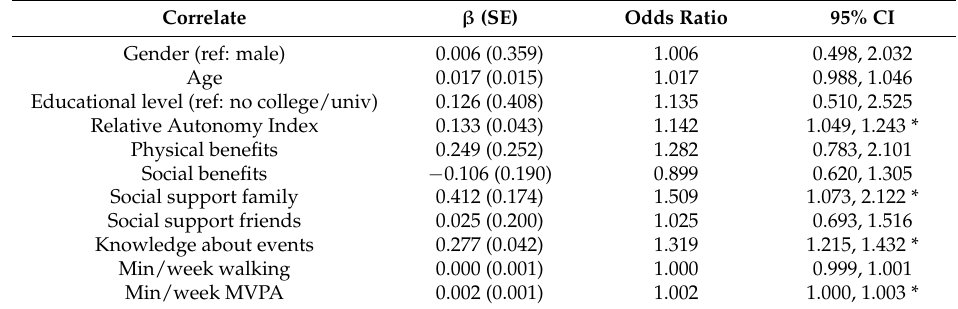
Table 2. Binary logistic regression analysis of socio-demographic, psychosocial and activity-related correlates of participation in running